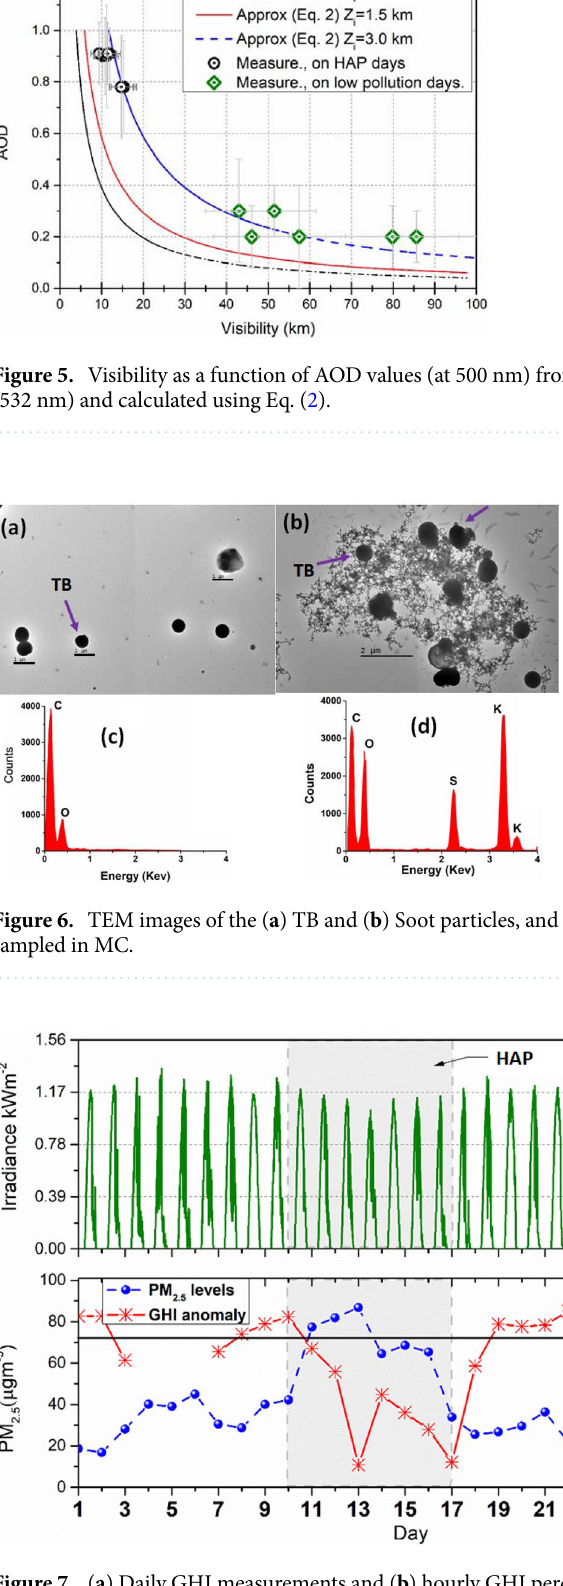
Figure 7. ( a ) Daily GHI measurements and ( b ) hourly GHI percent anomaly (solid red line) compared with the daily mean PM 2.5 concentration (blue dashed line) measured at the ICACC stations in MC during May